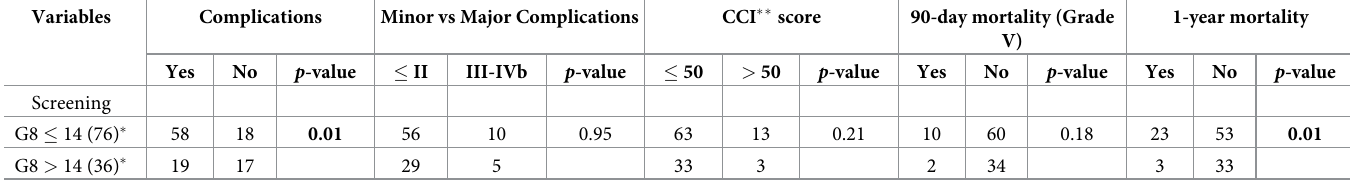
Table 4. Univariate analysis for predictors of complications, higher CD-Score, higher CCI score, 90-Day and 1-year mortality.